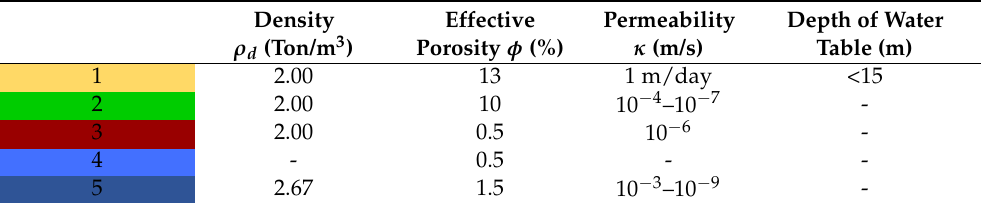
Table 1. Properties of the ground materials found in the 2D geological model.